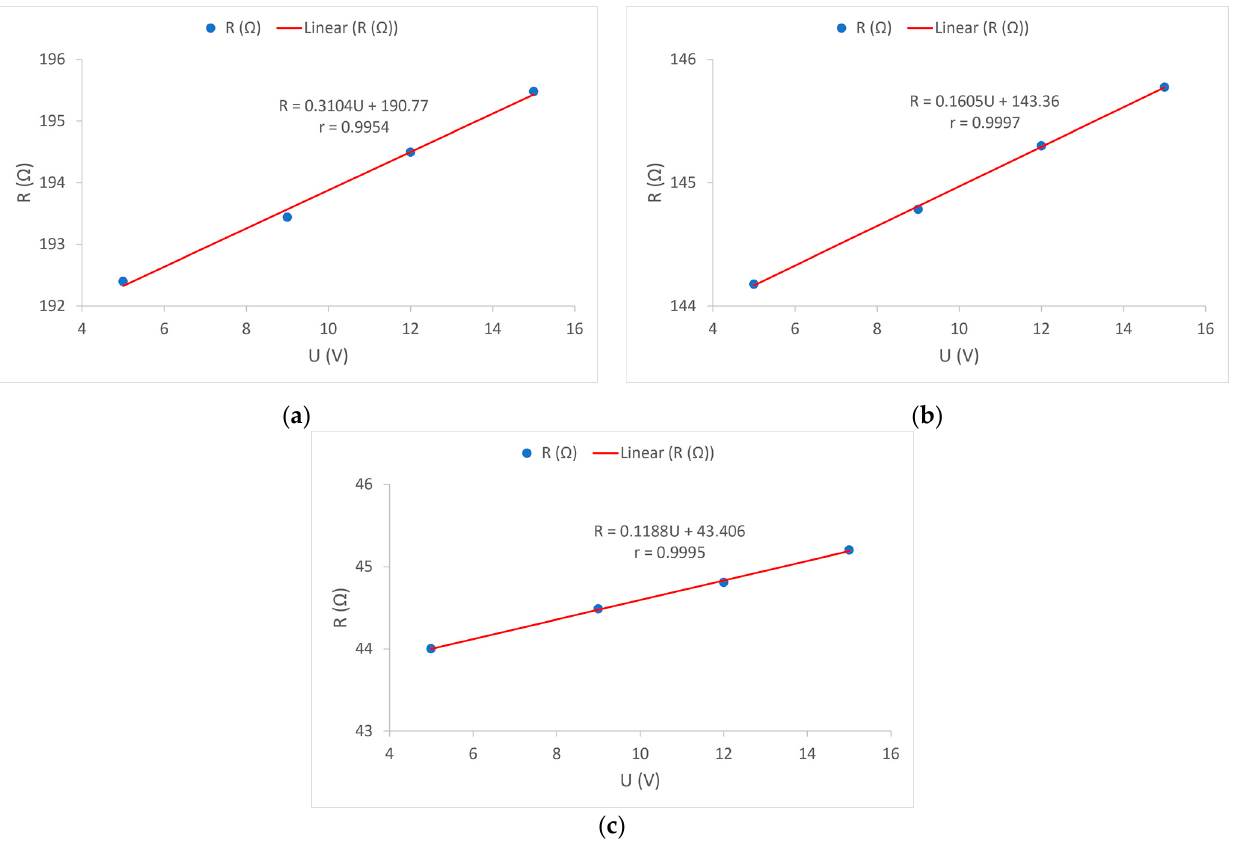
Figure 11. Comparison of three resistance values (start, average, and end) at given voltage values in sample 3.